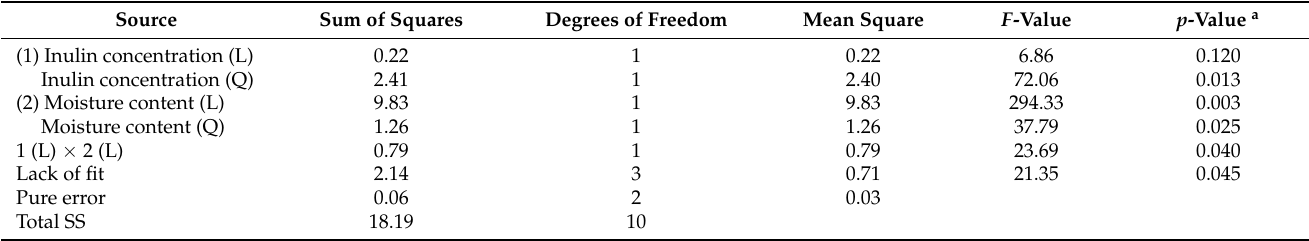
Table 5. Results of ANOVA apply to the second-order regression model fitted to experimental data of inulinase production by Aspergillus terreus URM4658 in solid-state fermentation using wheat bran as a substrate. Runs were performed according to the central composite rotational design outlined in Table 4.